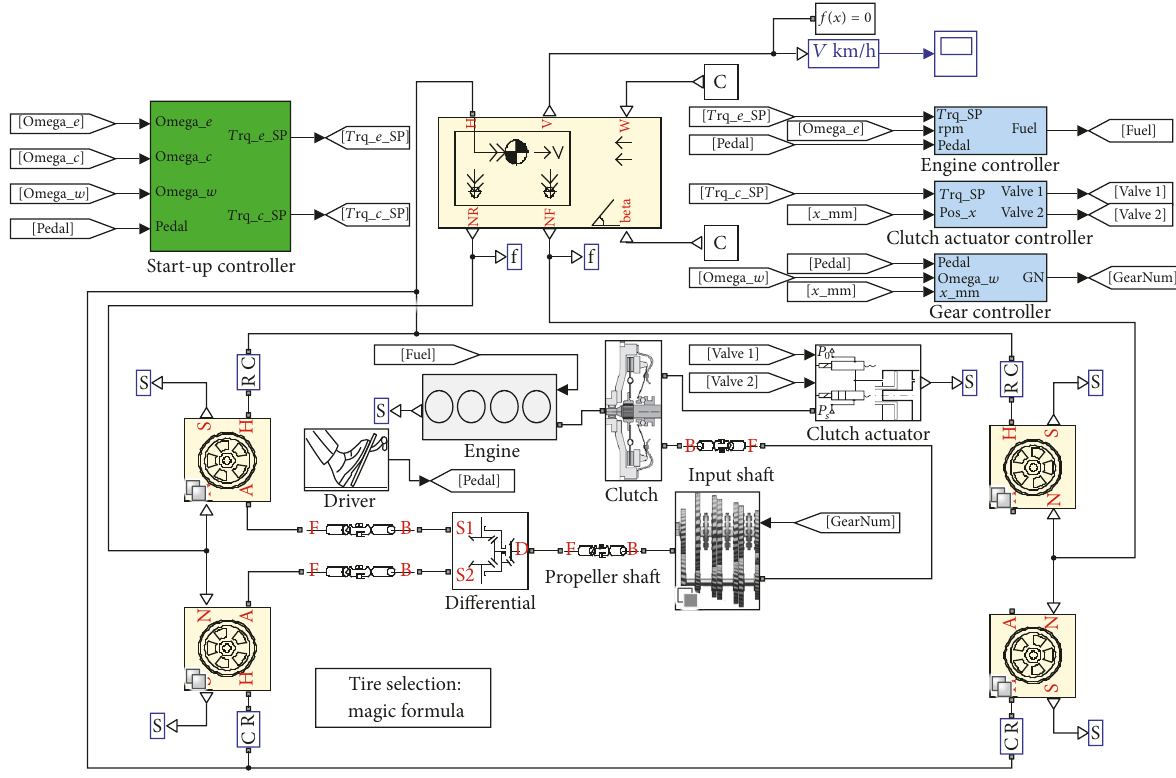
Figure 7: Simulation model of a heavy-duty truck.